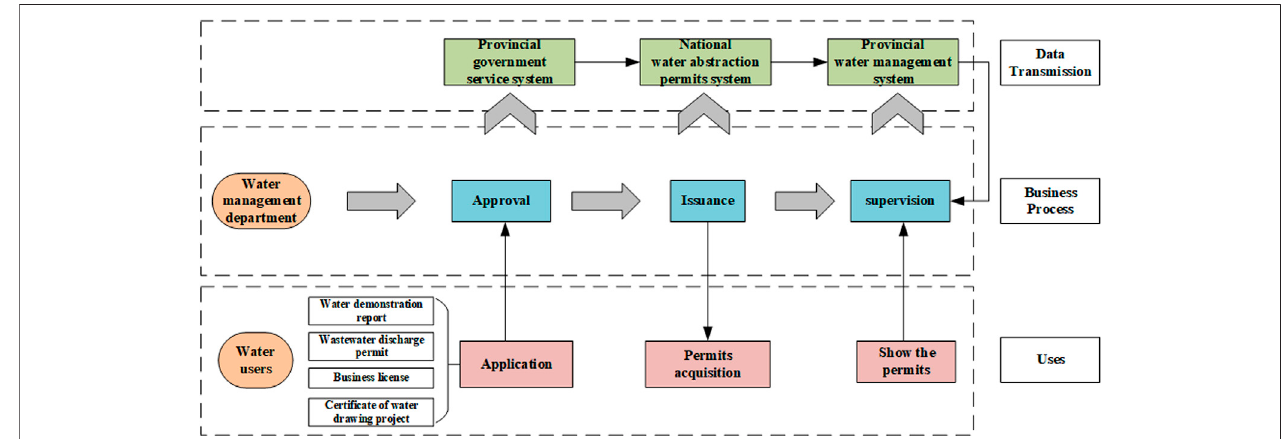
FIGURE 3 | The business process of electronic water abstraction permits in